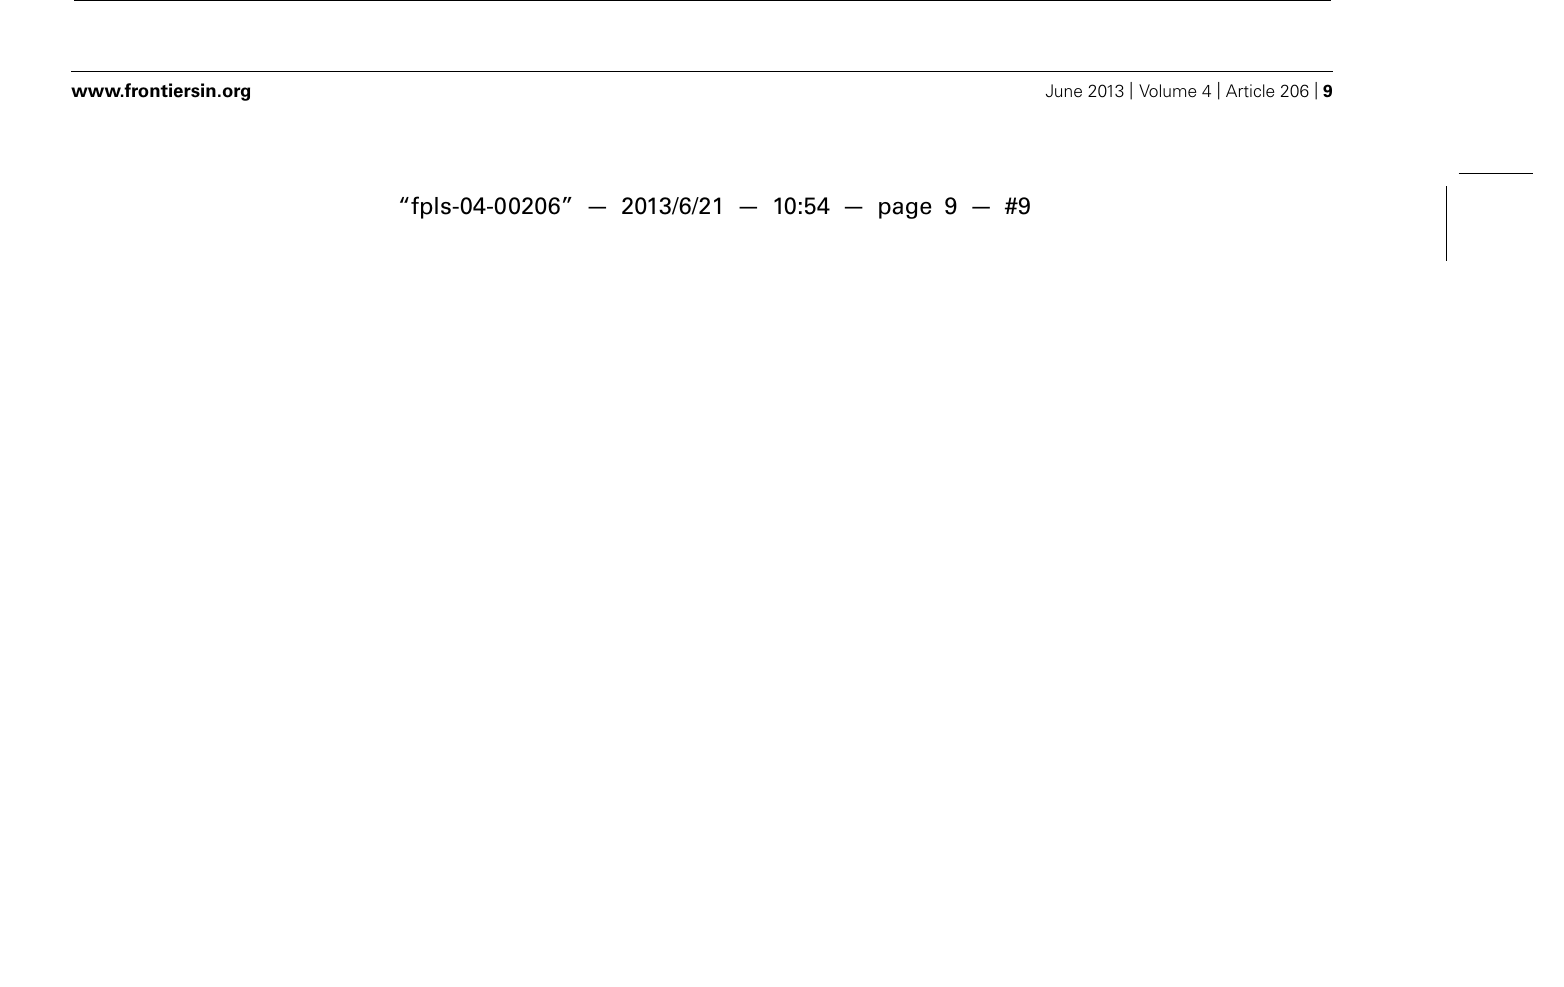
FIGURE 5 | Model for Trichoderma- induced resistance (TISR) against Botrytis cinerea in tomato. Root colonization with Trichoderma primes leaf tissues for enhanced activation of JA-regulated defense responses leading to a higher resistance to the necrotroph. Intact JA, SA, and ABA signaling pathways are required forTISR